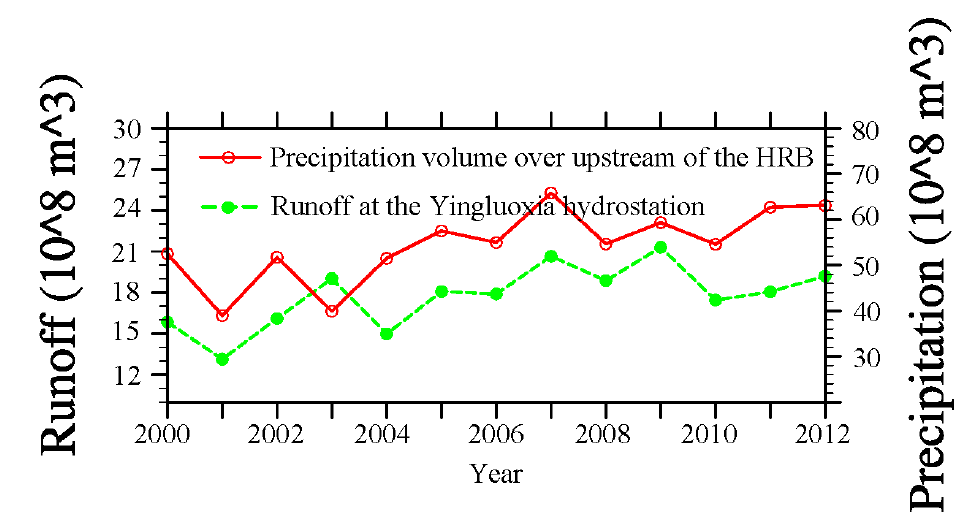
Figure 7. Accumulated annual precipitation curves over the HRB and in up-, mid-, and downstream areas from 2000 to 2013.